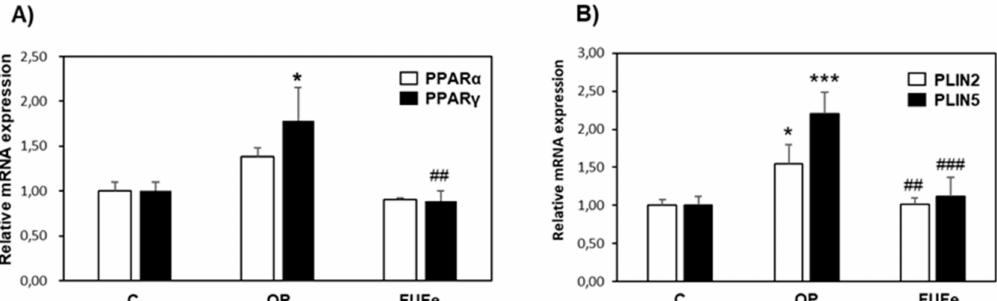
Figure 3. Effects of FUFe on hepatic gene expression. The relative mRNA expression of ( A ) PPAR α and PPAR γ and ( B ) PLIN2 and PLIN5 was quantified by qPCR in control (C) and steatotic FaO cells incubated in the absence (OP) or in the presence (FUFe) of 50 µ g/mL FUFe for 24 h. Data are expressed as fold induction with respect to controls. Values are mean ± S.D. from three independent experiments. Significant differences are denoted by symbols: * p ≤ 0.05, *** p ≤ 0.001 vs. C; ## p ≤ 0.01, ### p ≤ 0.001 vs. OP.